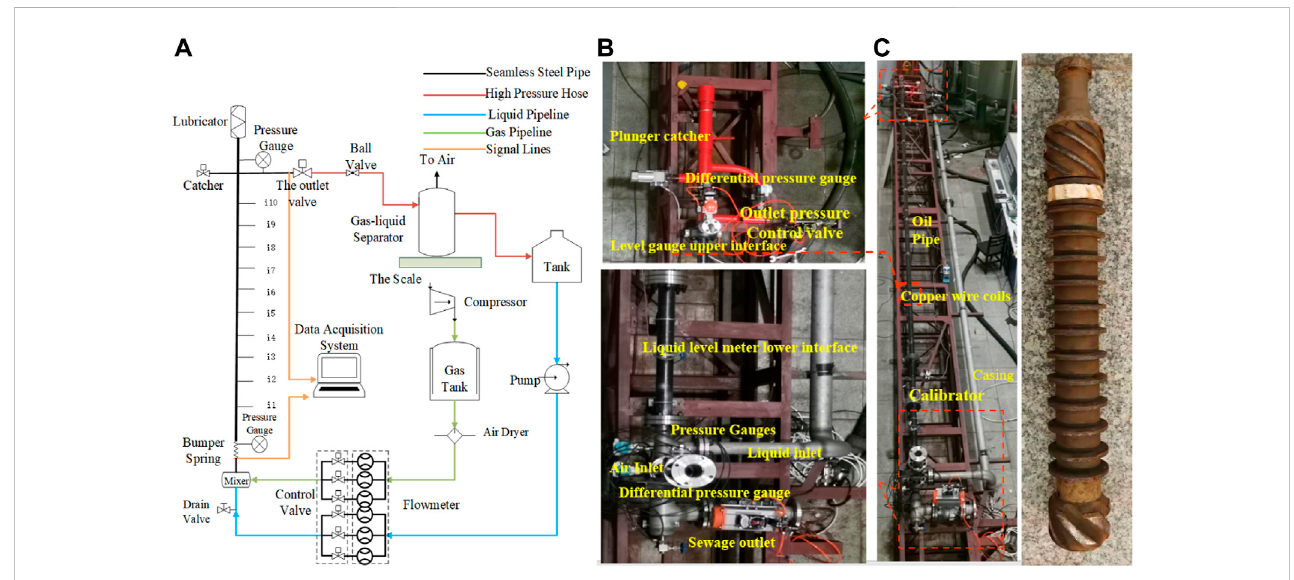
FIGURE 1 Reconstructed plunger gas lift stand. (A) . Schematic diagram for plunger gas lift test (B) . Simulated wellbore (C) . Rod-like streamlined